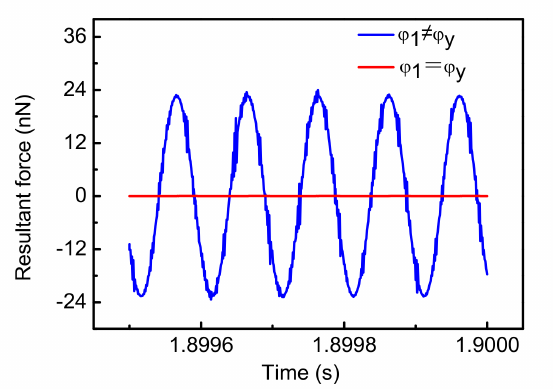
Figure 12. The resultant force at different demodulation phase angles.